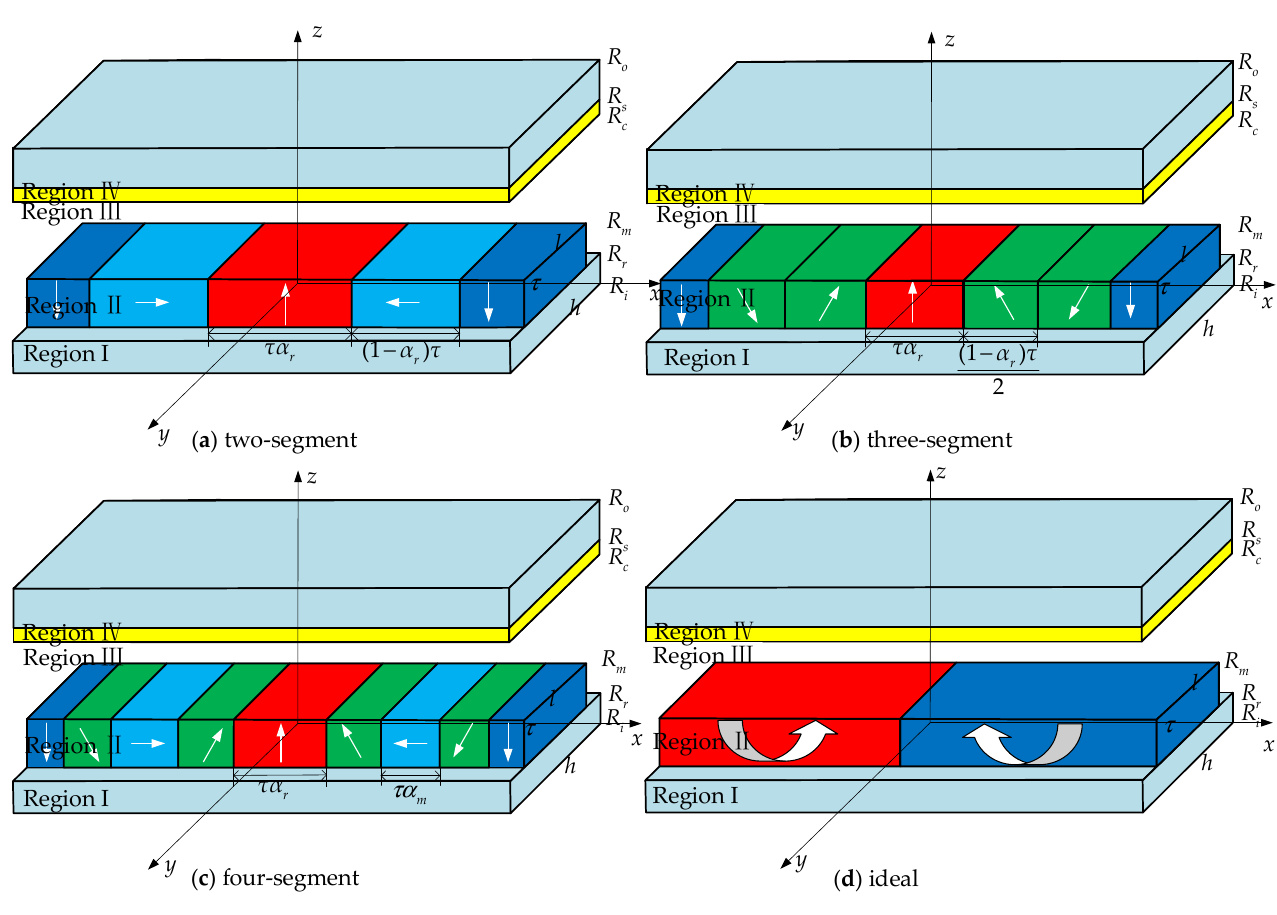
Figure 3. Magnet arrays with different Halbach arrays.